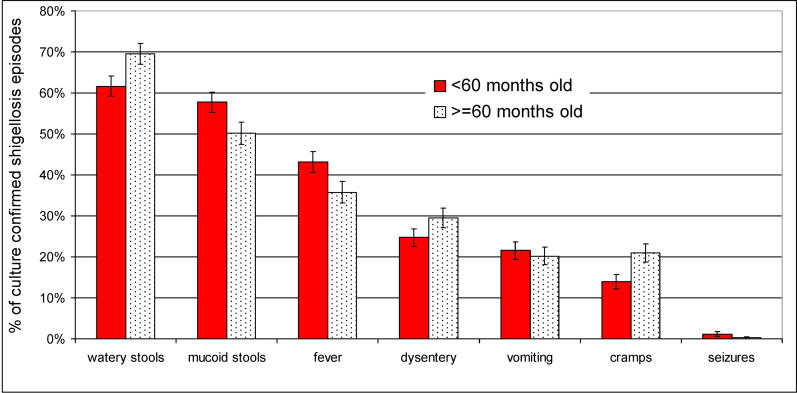
Clinical Presentation of Shigellosis EpisodesA history of more than one clinical sign and symptom during a single episode is possible.